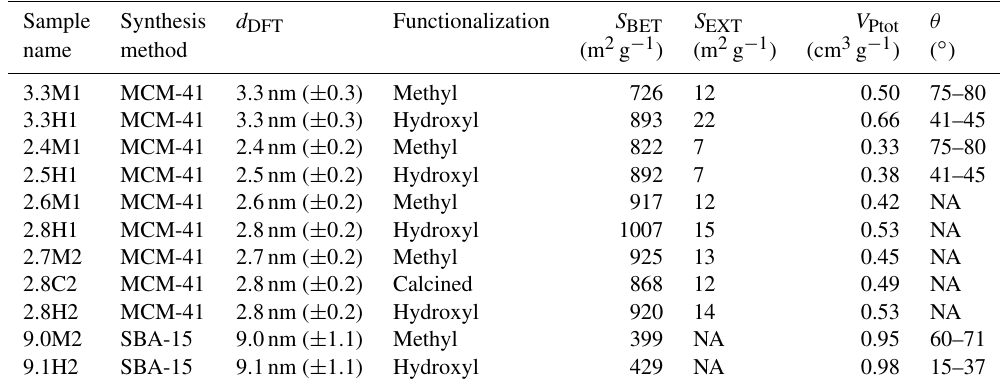
Figure 2. Panel (a) shows pore size distributions for the 2.8nm sample after calcination (grey), hydroxylation (blue) and methylation (gold). Panels (b) and (c) show pore size distributions of the hydroxylated and methylated samples, respectively. Panel (d) shows the pore size distribution for the SBA-15 samples after hydroxylation (magenta) and methylation (red). Table 1. Summary of samples used for ice nucleation studies. The BET method was used for total surface area ( S BET ) and α s plot for external